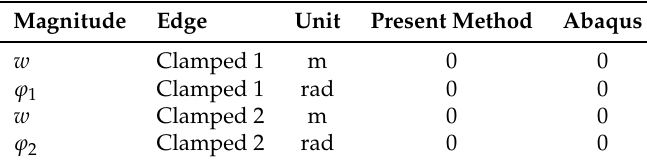
Table 6. Compliance with boundary conditions at the midpoints of the edges.